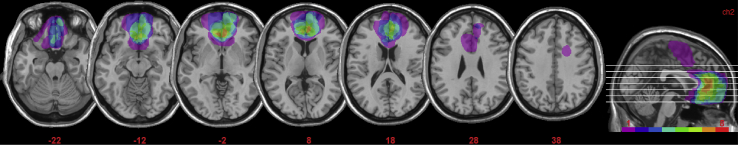
Representative axial slices and cumulative midsagittal view of the standard Montreal Neurological Institute brain showing the extent of lesion overlap in the vmPFC patients. The white horizontal lines on the sagittal view are the positions of the axial slices, and the red numbers below the axial views are the z coordinates of each slice. The color bar indicates the number of overlapping lesions. Maximal overlap occurs in BA 10, 11, and 32. The left hemisphere is on the left side.